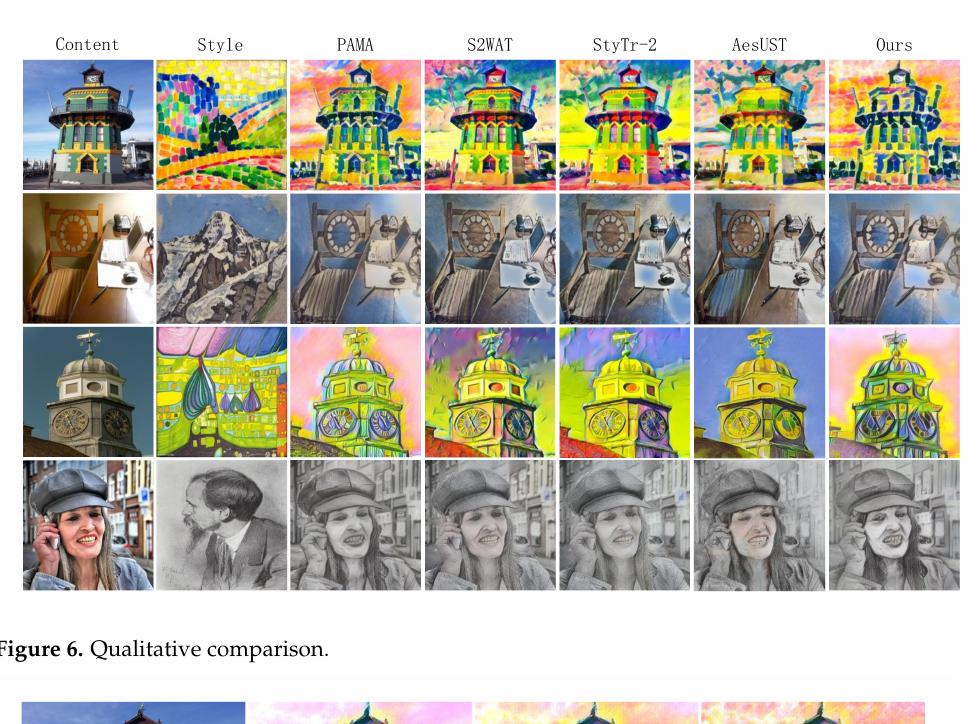
Figure 6. Qualitative comparison.